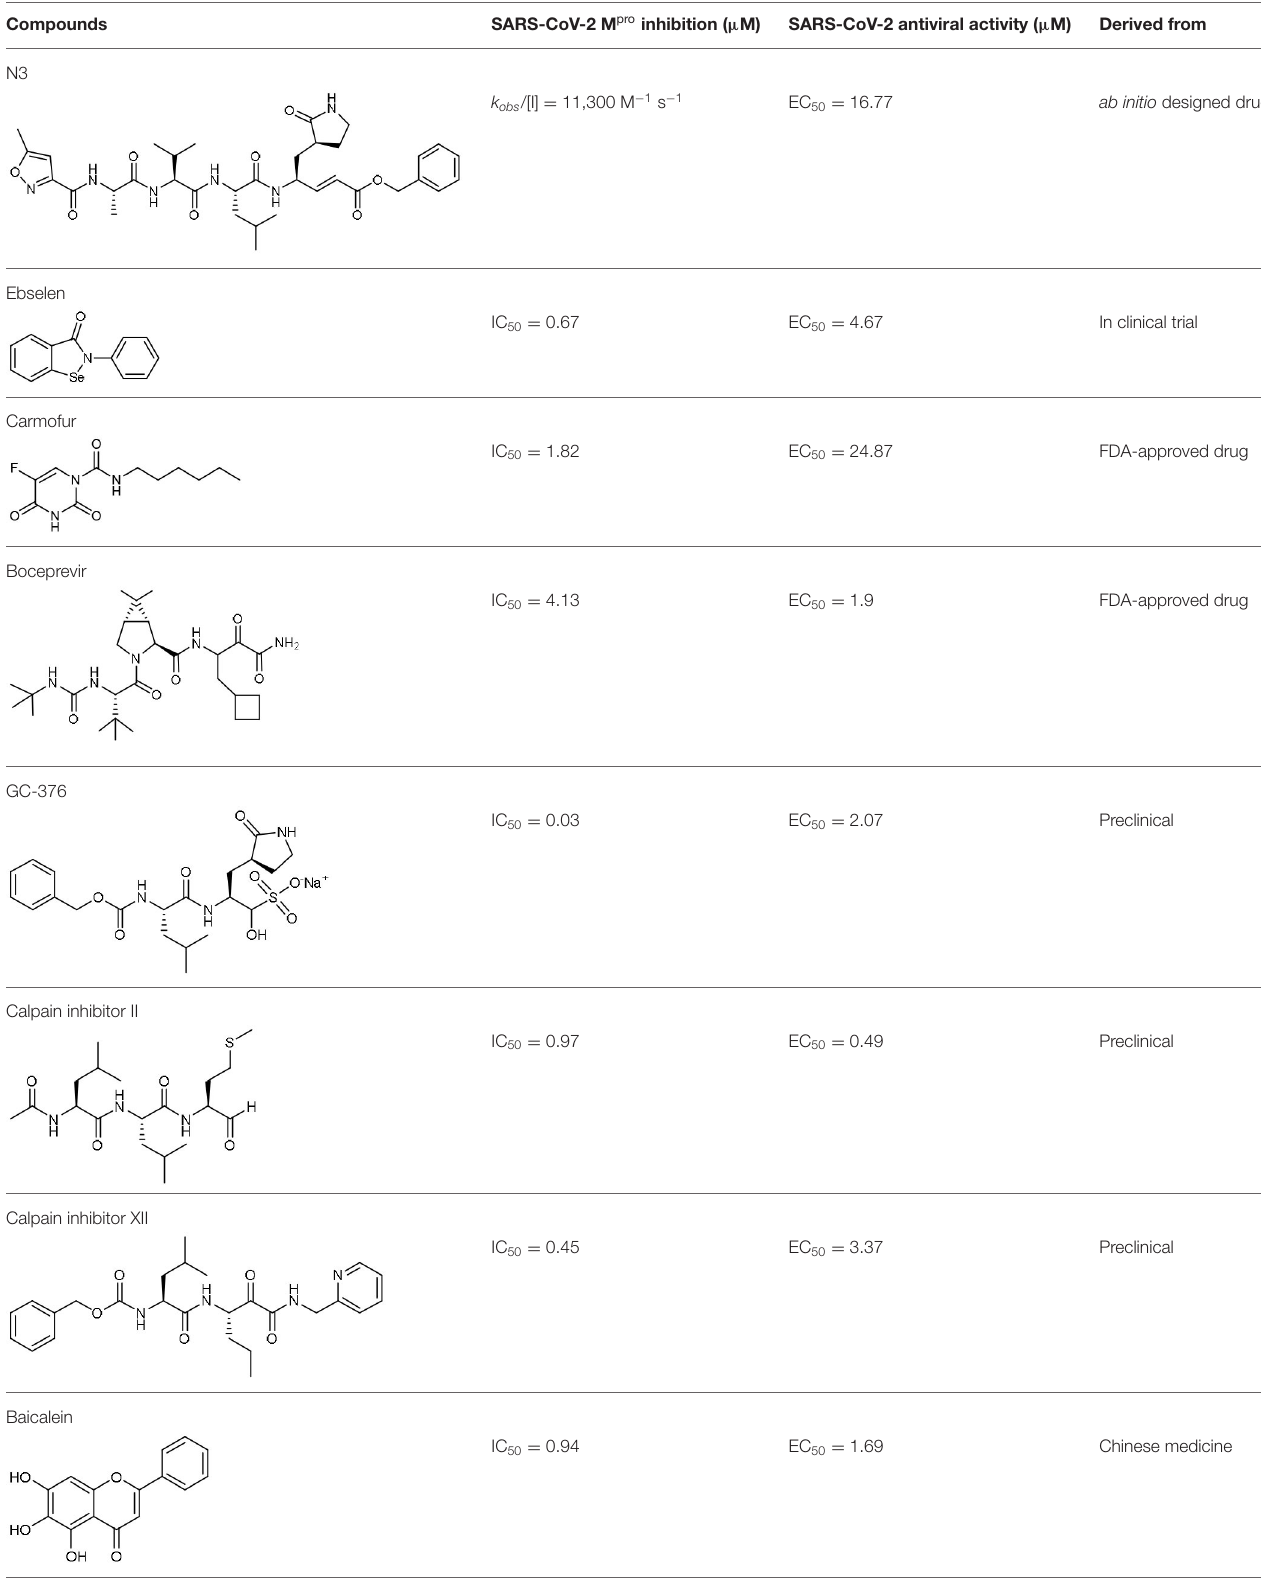
TABLE 1 | Antiviral activity of newly discovered hits against SARS-CoV-2.